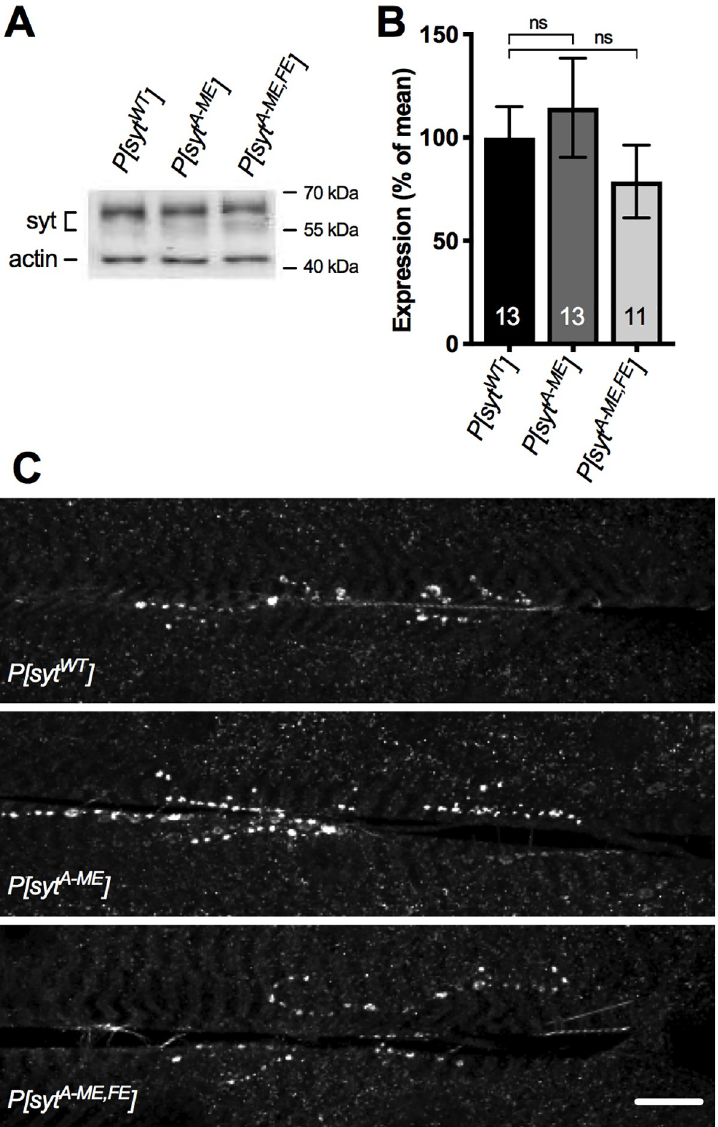
Fig 3. Expression and localization of synaptotagmin are unaffected by hydrophobic mutations. A, Representative western blots of transgenic synaptotagmin expression levels with actin as a loading control. B, Mean protein expression levels ± SEM, normalized to actin (One-way ANOVA, no significant differences). C, Representative confocal images of larval neuromuscular junctions labeled with anti-synaptotagmin antibodies (scale bar = 20 μ m). Synaptotagmin is appropriately concentrated at synaptic sites in all three